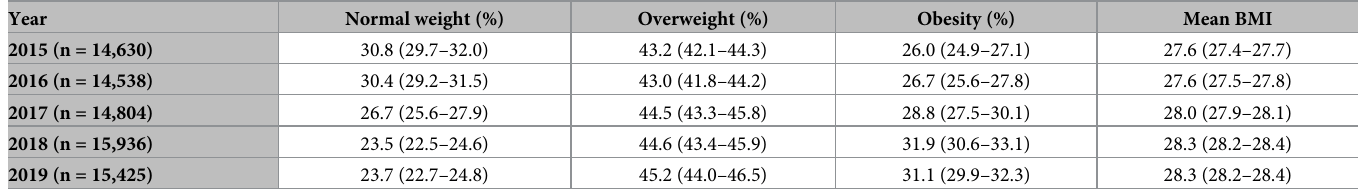
Categories are presented as prevalence estimates in percentages along with the 95% confidence interval. Mean BMI is also presented along with the 95% confidence